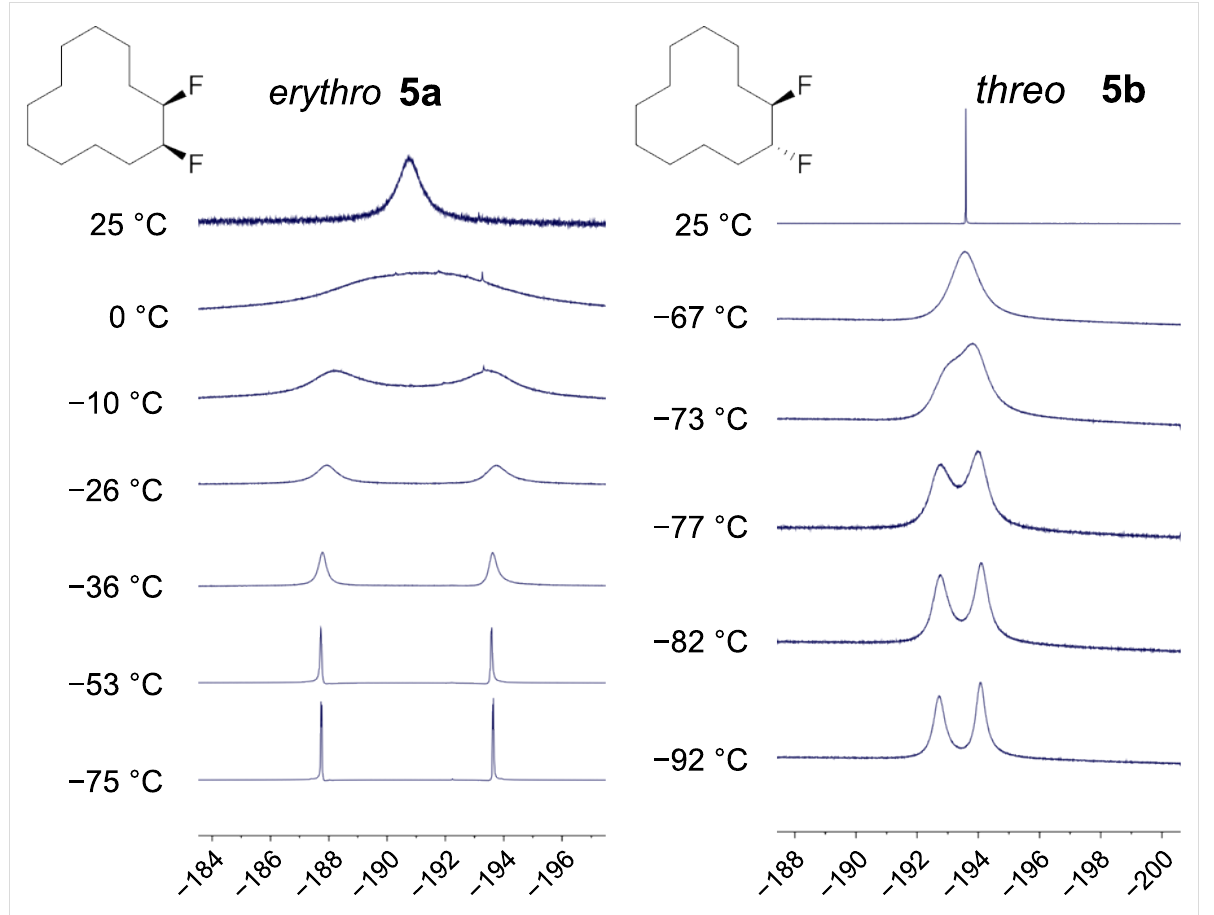
Figure 5: Variable-temperature 19 F{ 1 H} NMR of erythro- ( 5a ) and threo -1,2-difluorocyclododecane ( 5b ).